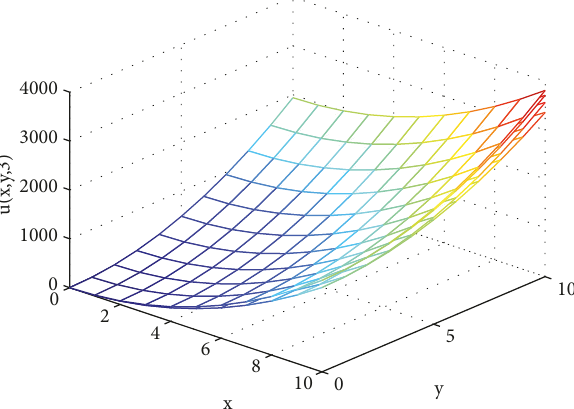
Figure 5: The approximate solutions 𝑢 9 , 𝑢 10 , 𝑢 11 , and 𝑢 12 of (49) at 𝑡 = 3 with 𝛼 = 1/2 .